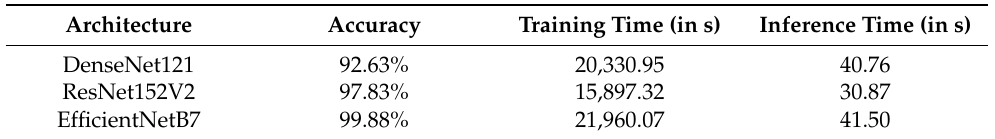
Table 8. Classification comparison on CT scan modality using different architectures in terms of accuracy and execution